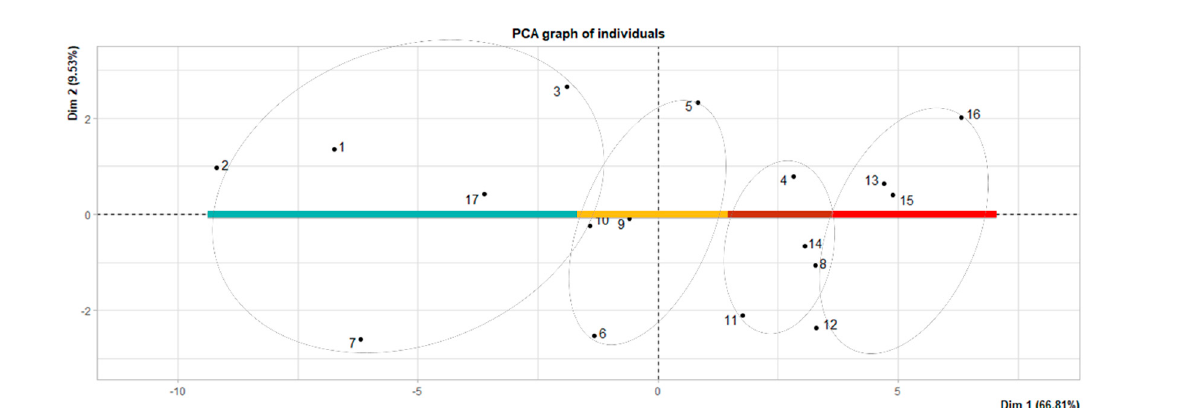
Figure 8. PCA graph of individuals.